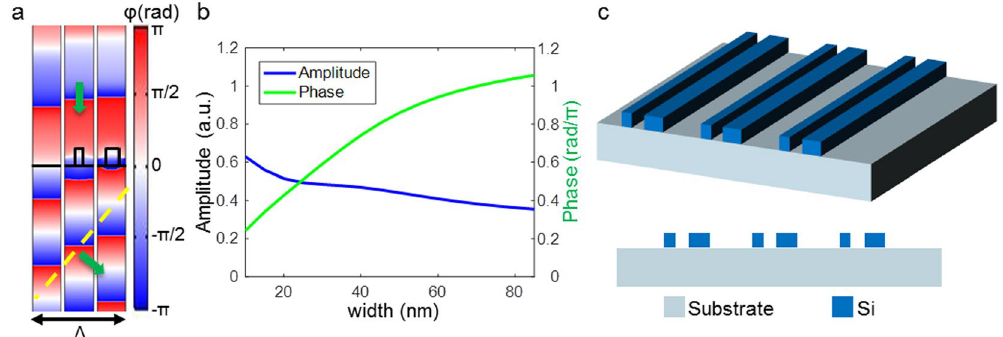
Figure 1. Design of transmission mode metasurfaces with a large steering angle. ( a ) Phase wavefronts of the TM-polarized transmission mode metasurface at a 520-nm wavelength without the Si nanobeams, and with an array of nanobeams of 30 nm and 55 nm widths respectively spaced by 125 nm. ( b ) The variation of the phase delay and amplitude of the transmitted light versus the width of the Si nanobeams. ( c ) Schematic of the designed metasurface, which consists of two nanobeams with a thickness of 75 nm and widths of 30 nm and 55 nm, with an edge-to-edge gap of 85 nm and periodicity of 380 nm. The bottom inset shows the side view of the